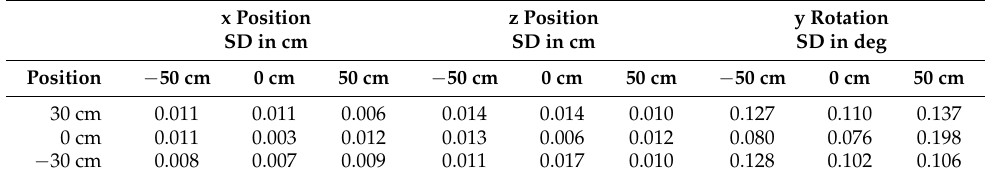
Table 1. Standard deviation of the position and rotation of the sensor box during the precision evaluation. x Position